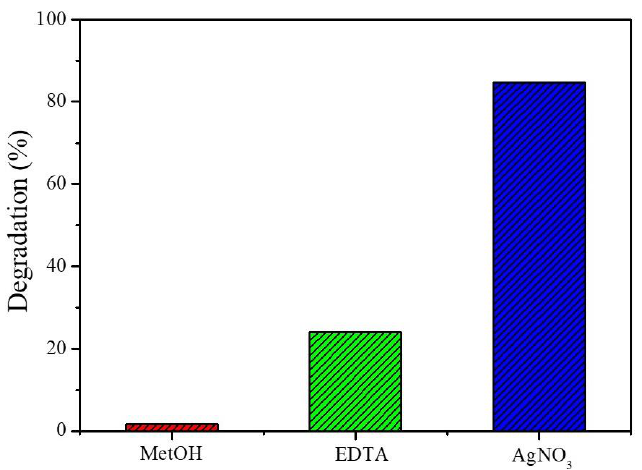
Figure 5. Photocatalytic systems containing different inhibitor reagents.